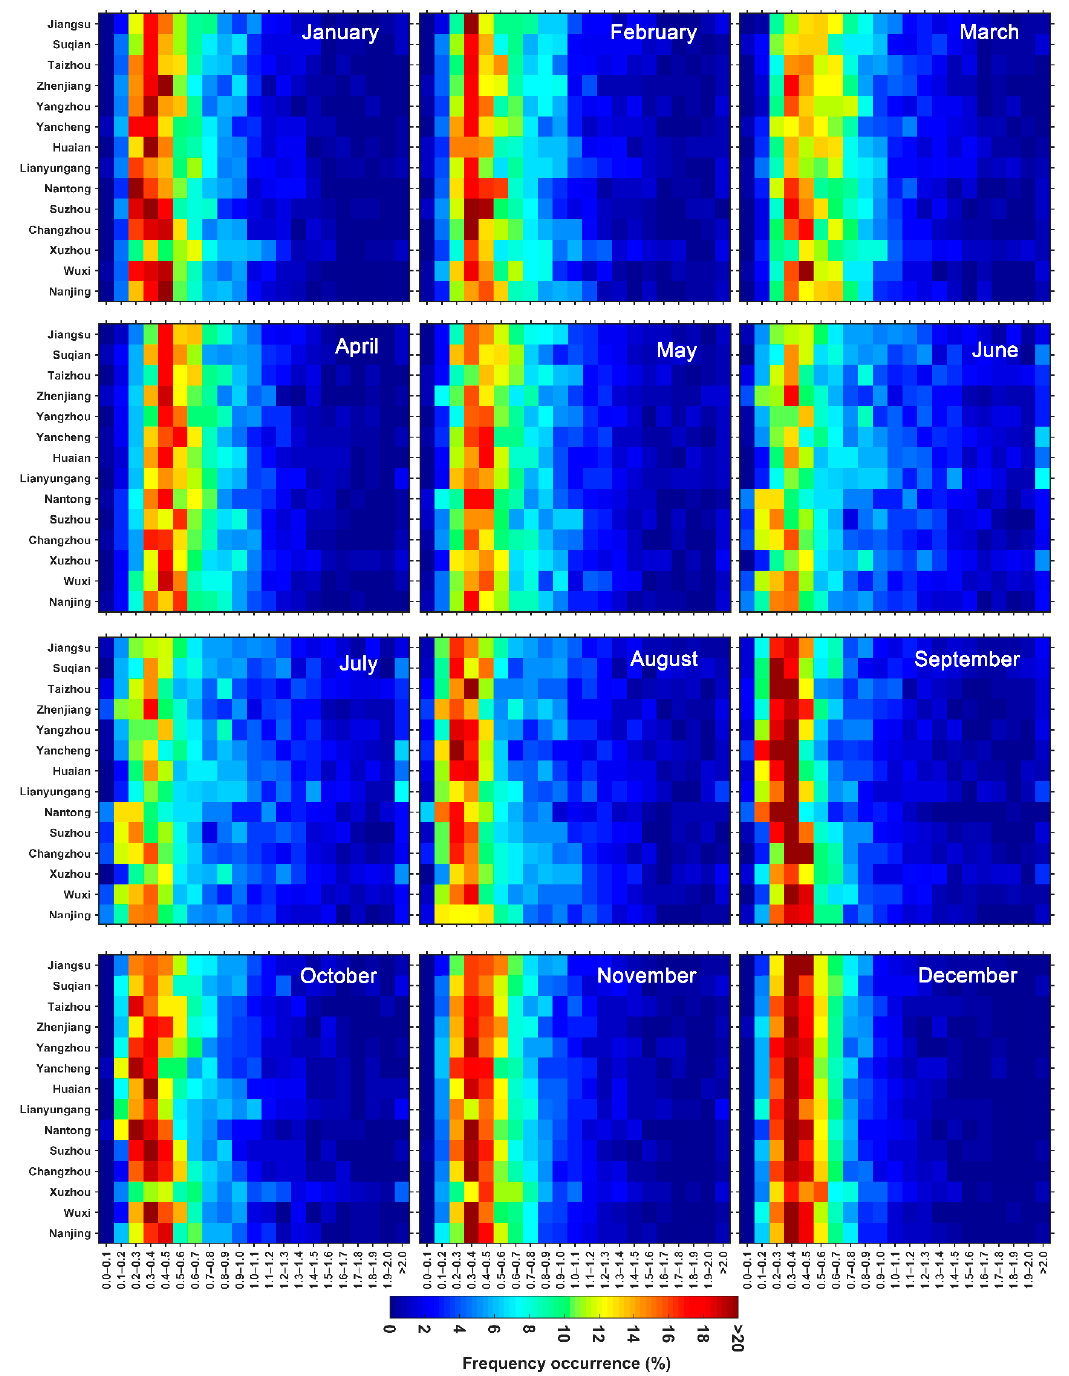
Figure 7. Monthly frequency distribution of high-resolution MODIS MAIAC AOD in 13 cities in Jiangsu Province from 2000 to 2020.